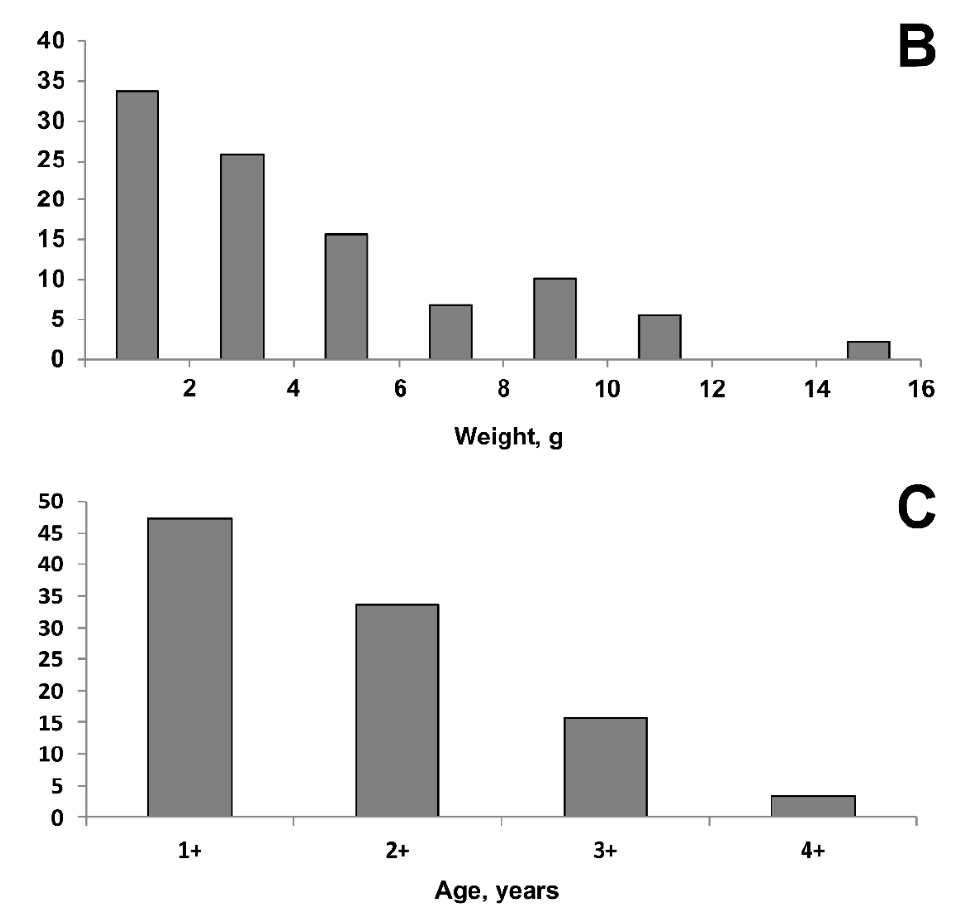
Figure 5. Size ( A ), weight ( B ), and age ( C ) compositions of ribbed sculpin Triglops pingelii in the Kara Sea, September 2019.